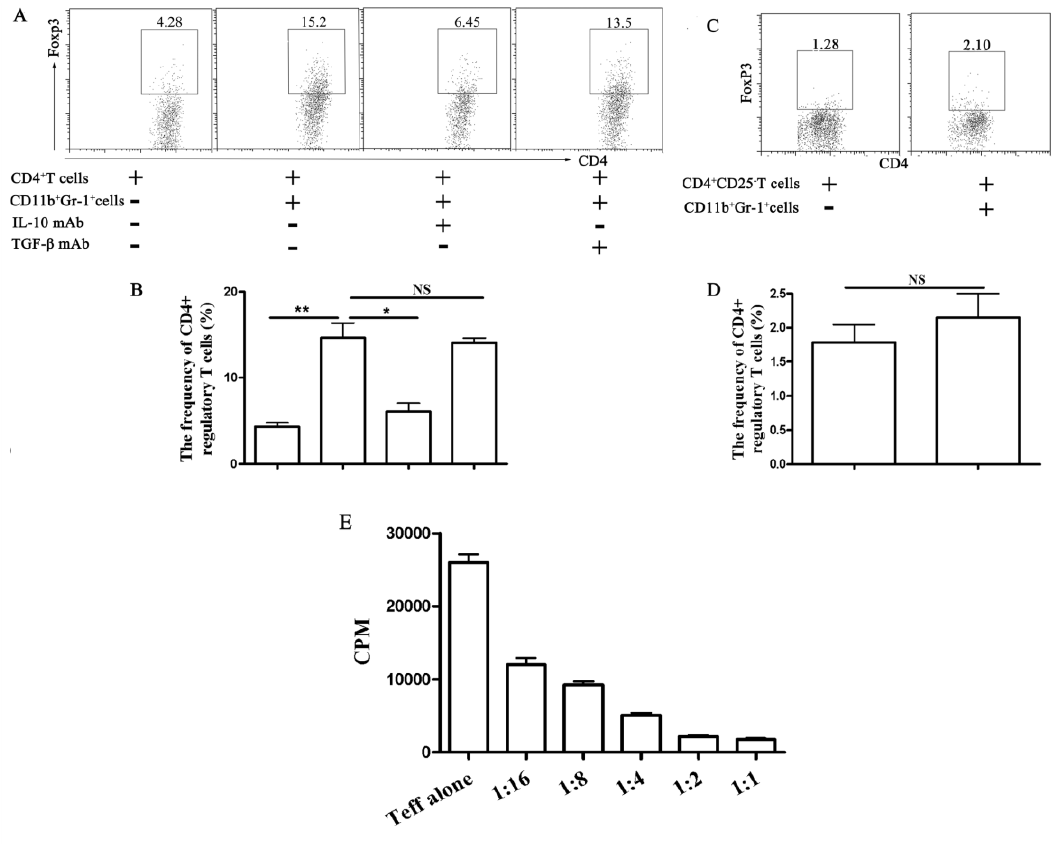
Figure 5. The effect of CD11b + Gr-1 + myeloid suppressor cells in galectin-9-treated mice on the induction of Tregs. For induction of Tregs in vitro , CD4 + or CD4 + CD25 − T cells were isolated from splenocytes using the CD4 + CD25 + T cell Isolation Kit. The isolated CD4 + T cells in RPMI 1640 with 10% heat-inactivated fetal bovine serum, IL-2 (20 ng/mL), anti-CD28 (2 μg/mL) were distributed into anti-CD3 coated 96-well plate at 2 × 10 5 cells/well in the presence or absence of TGF-β mAb (1 μg/mL), IL-10 mAb (20 ng/mL) and co-cultured with isolated CD11b + Gr-1 + myeloid suppressor cells for 4 days at 37 °C in an atmosphere containing 5% CO . Then the percentage of CD4 + CD25 + Foxp3 + 2 cells was detected by FACS ( A – D ), and ( E ) The ability to suppress the proliferation of CD25 − CD4 + T cells was tested with FACS-sorted populations of expanded CD4 + CD25 high T cells. CD4 + CD25 − T cells were incubated in the presence of anti-CD3 and anti-CD28. Proliferation was determined with 3 H-thymidine incorporation. In co-incubation, increasing numbers of CD4 + CD25 high T cells were added to a constant number of CD4 + CD25 − T cells at the ratios indicated. Data show the mean ± SEM. * , p < 0.05; ** , p < 0.01; NS: no significance; and Teff: effector T cells. Similar results were obtained in three separate experiments and the representative results are indicated in ( A ) and ( C